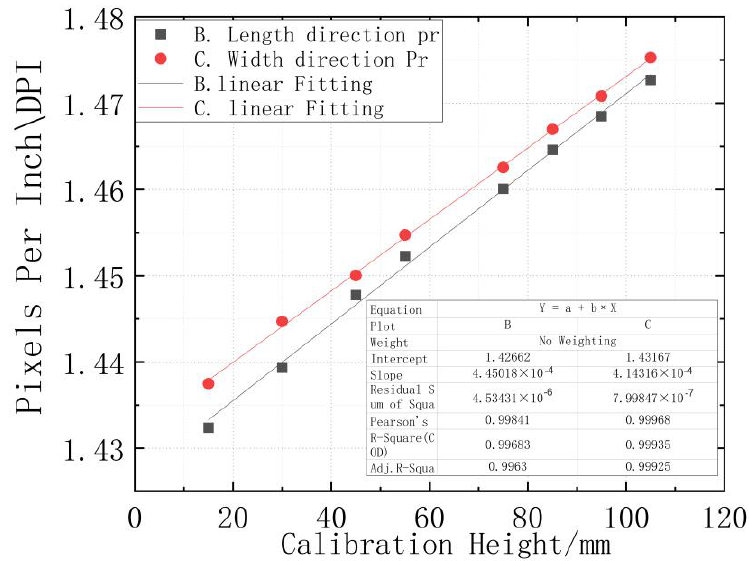
Figure 13. Relationship between length–width pixel ratio and calibration plate